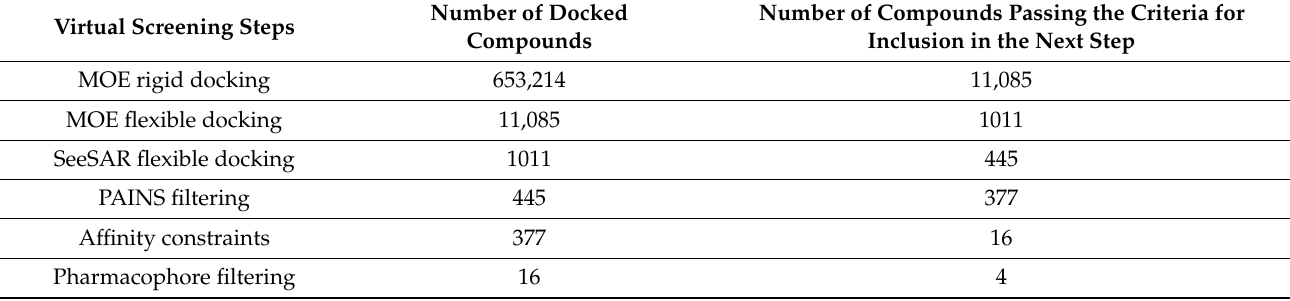
Table 2. Results of the multi-step VS with the number of triple-acting compounds remaining after each